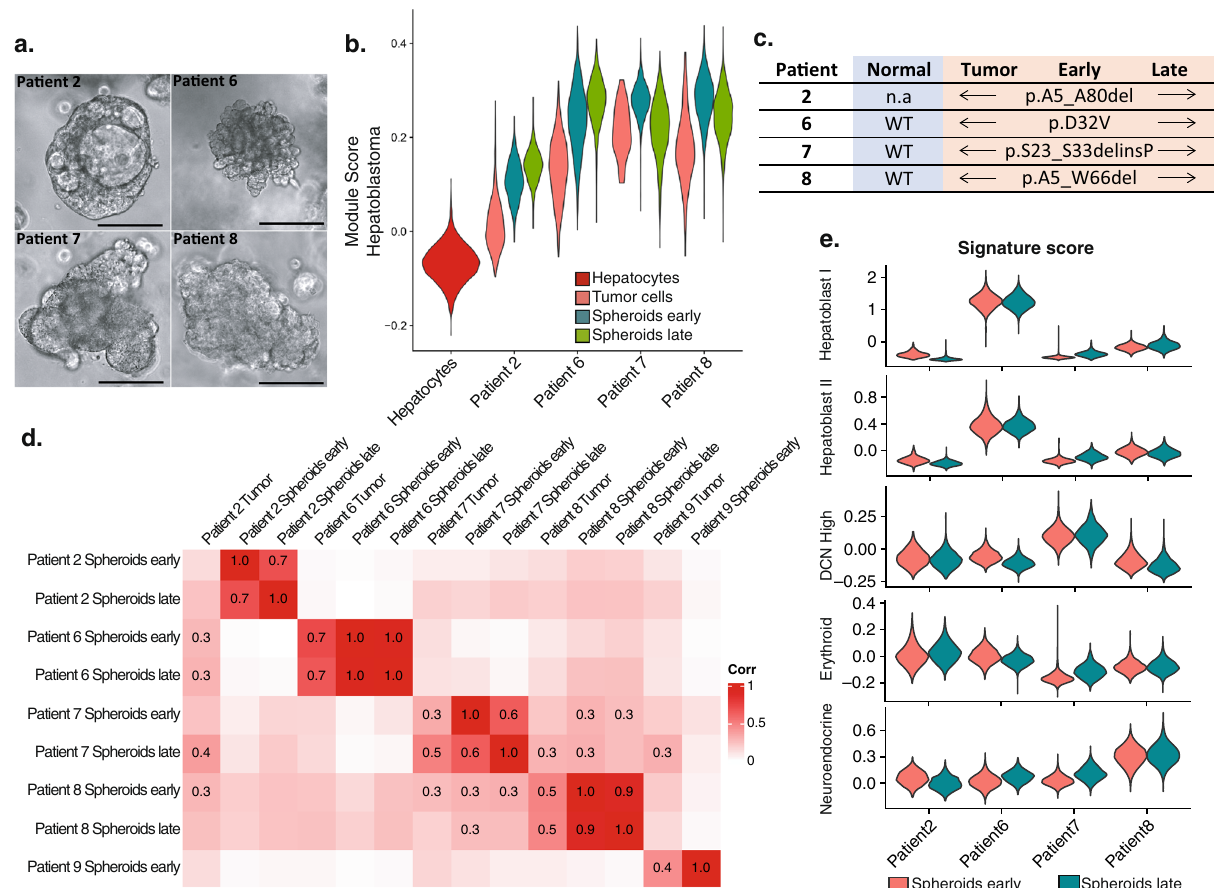
Fig. 5 | Patient-derived-spheroids maintain patient-speci fi c features from freshly isolated parent cells. a Bright fi eld images of tumor spheroids from patients 2, 6, 7, and 8 at early passage. Scale bar = 100 μ m. b Violin plots of KEGG Cairo_Hepatoblastoma_UP signature score of tumor cells (patient 2) or spheroid parentcells(patients6,7,and8)orspheroidsfrompatients2,6,7,and8atanearly passage(passage2forpatients2,8,andpassage3forpatients6and7)andatalate passage(passage10forpatients2,6,and8,andpassage11forpatient7).Signature